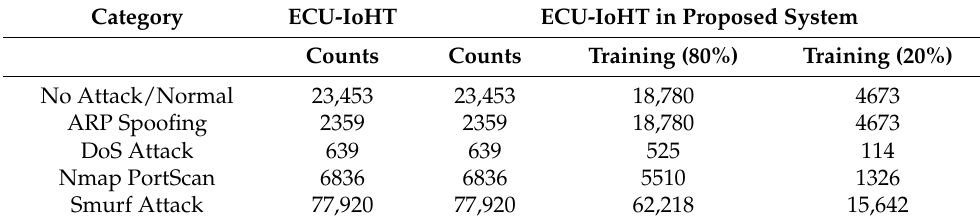
Table 1. Description of ECU-IoHT dataset.